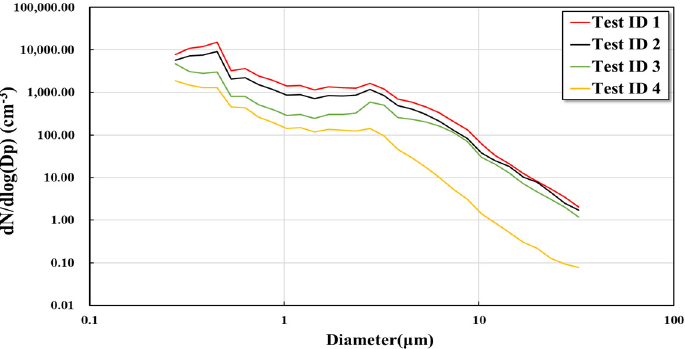
Figure 8. Particle number distribution as a function of diameter at different cutting depths.